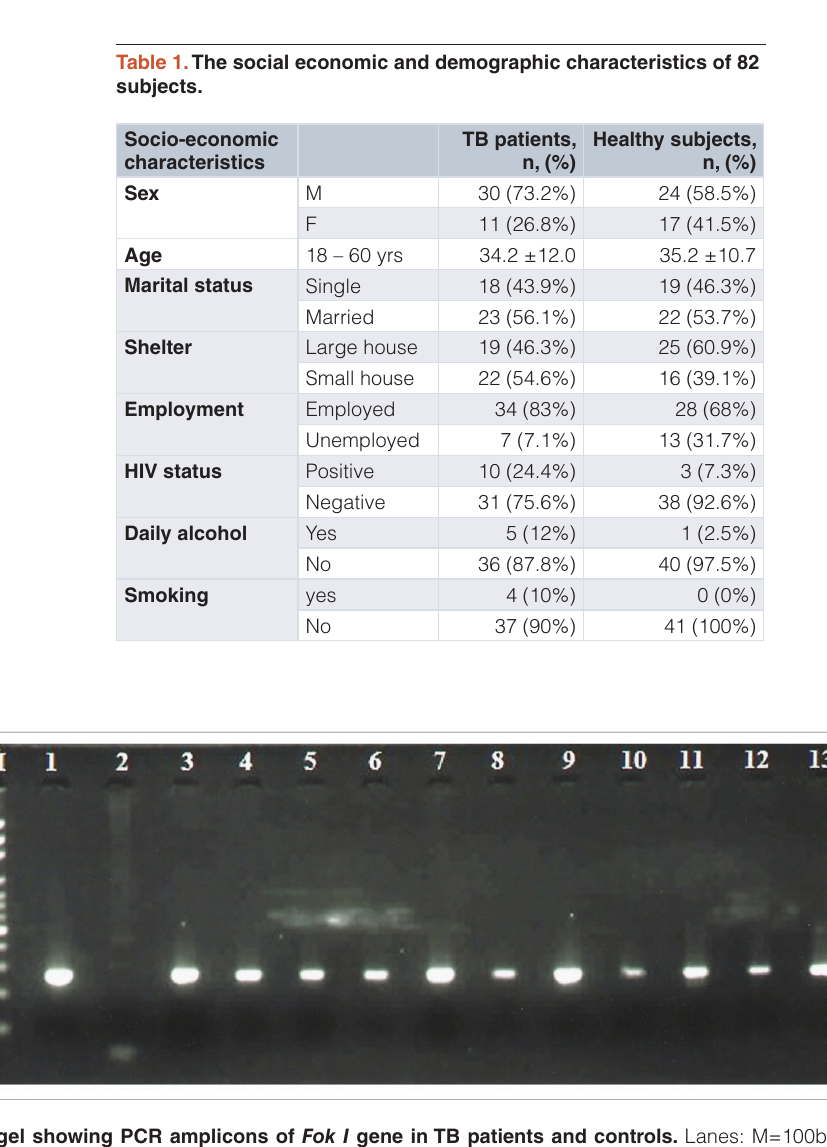
Figure 1. Agarose gel showing PCR amplicons of Fok I gene in TB patients and controls. Lanes: M=100bp DNA Ladder, 1=Positive Control, 2=Negative Control, 3–7 and 8–13 = Representative sequencing PCR products from controls and cases